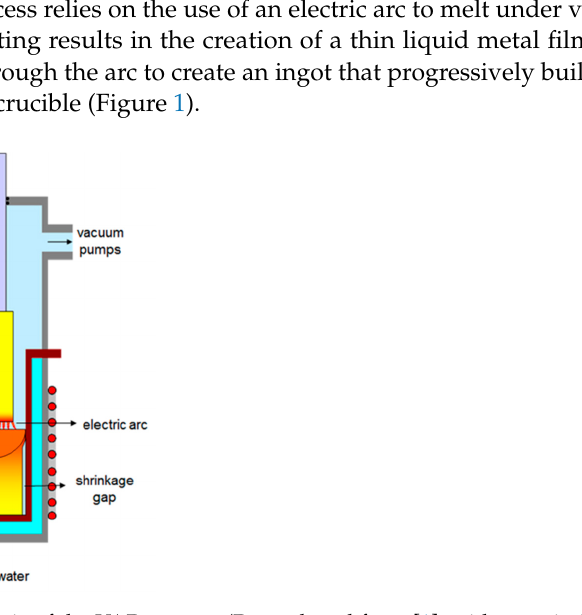
Figure 1. Schematic of the VAR process (Reproduced from [1], with permission from Elsevier, 2022). This process enables the production of ingots with reduced impurity content and segregation as well as a controlled microstructure. Note that for the melt of specific alloys (e.g., Ti and Zr alloys) an external axial magnetic field is used to confine the arc under the electrode and to promote stirring and homogenization of the metal in the liquid pool present at the ingot top. Among the process conditions, the characteristics of the arc play a crucial role in the operation and performance of the process. They determine the spa- tio-temporal distributions of the current and thermal energy inputs at the top of the in- got, which both affect, through controlling the hydrodynamics and the thermal field of the liquid metal, the ingot solidification conditions and, thus, its final quality [2]. Despite the central importance of the electric arc in the process, the characteristics and the role of the arc have been little investigated in the literature. The experimental study of the electric arc in a VAR furnace is indeed extremely challenging due to the furnace configuration (with no direct visual access to the arc) and the hostile conditions (high temperature and low-pressure conditions) inside the furnace. Consequently, the knowledge regarding the arc behavior is very scarce. At small time scales (less than a few milliseconds), it has been established due to direct visualization experiments performed in specifically instrumented furnace that the arc consists of multiple tiny cathode spots producing a diffuse metal vapor plasma that enables the electrical current transfer between the electrode and the ingot, each spot carrying a current of the order of 100 A [3–5]. Due to the fast motion of the cathode spots over the whole electrode surface, such an arc behavior was thought to provide a mac- ro-uniform heat and electrical input at the ingot top [6]. This latter conclusion was however put under questions by several studies per- formed on industrial VAR furnaces, which succeeded to infer unexpected results on the spatio-temporal-distribution of the arc at large time scales. These latter studies relied ei- ther on magnetic flux measurements outside the furnace or optical techniques. Magnetic flux measurements revealed that the arc centroid was most of the time off-centered and rotated around the electrode centerline with a time period of approximately 20–40 s during VAR of Inconel 718 [7] and 1–20 s during VAR of a Ti64 alloy [8]. More recently, using an optical technique inspired from that proposed by Aikin and Williamson [9], we reported similar results during VAR of a Ti64 alloy showing the existence of an asym- metrical arc distribution with a periodic ensemble arc motion leading to various arc pat- terns [1].